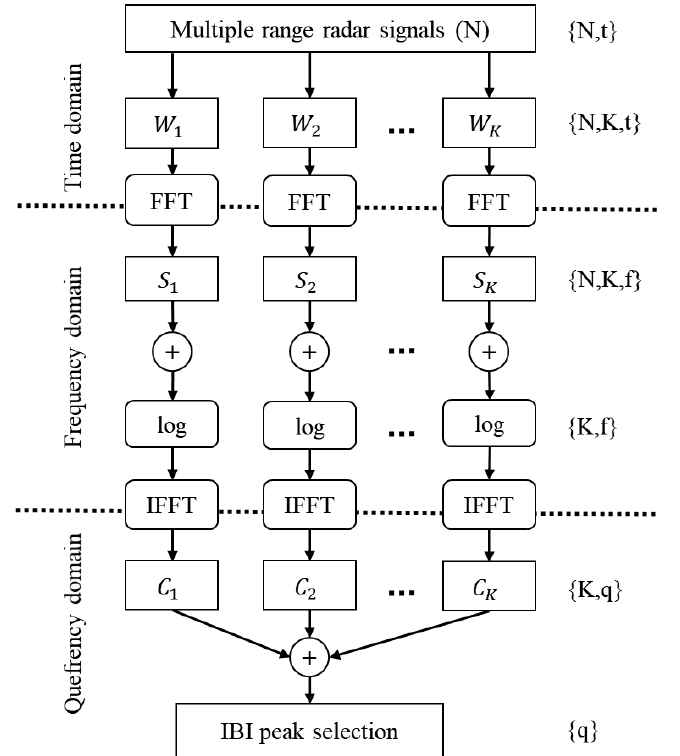
Figure 4. Interbeat interval extraction from a set of N range signals using K Fast Fourier Transform (FFT) windows. The process is repeated using overlapping FFT windows. The notations on the right represent the data dimensions at each phase; t denotes time, f frequency, and q the cepstrum lag time, or